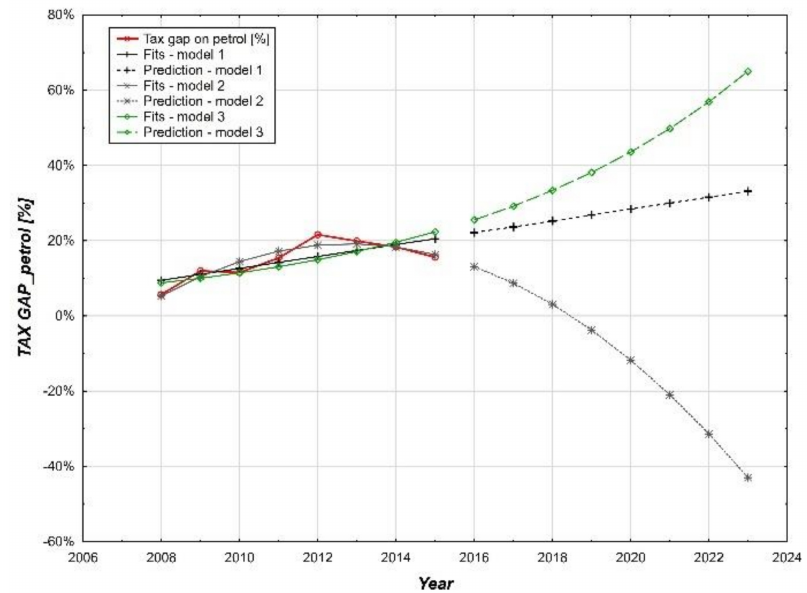
Figure 12. Prediction of the value of TAX GAP_petrol (%) in the years